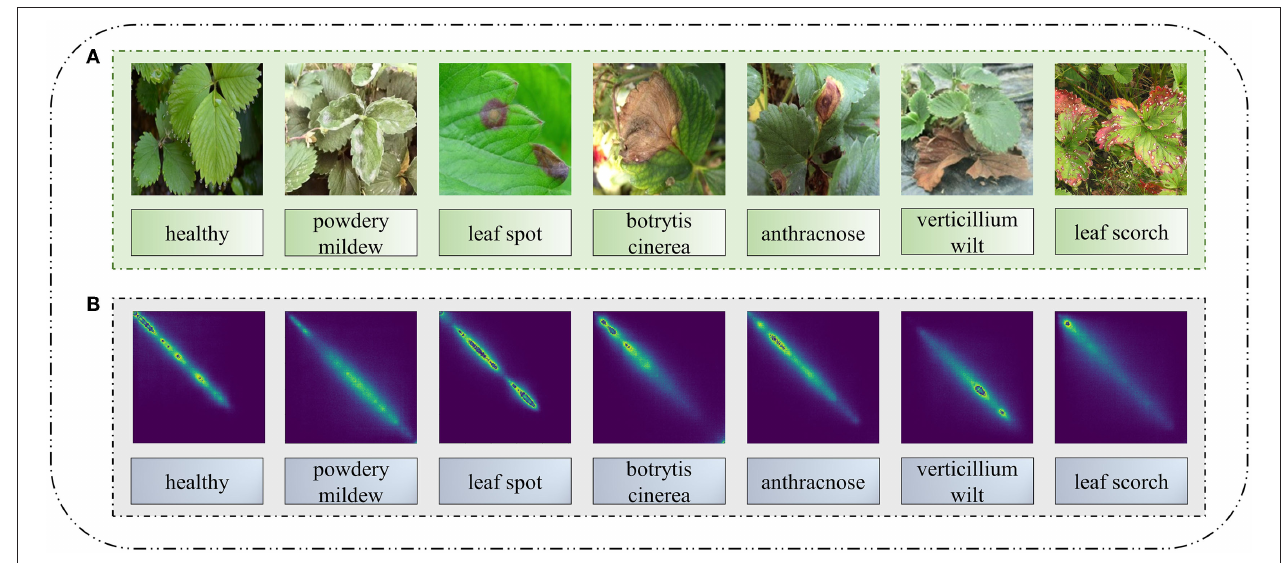
FIGURE 3 | (A,B) Color feature map corresponding to five different strawberry leaf disease images. A color correlogram can be understood as a table indexed